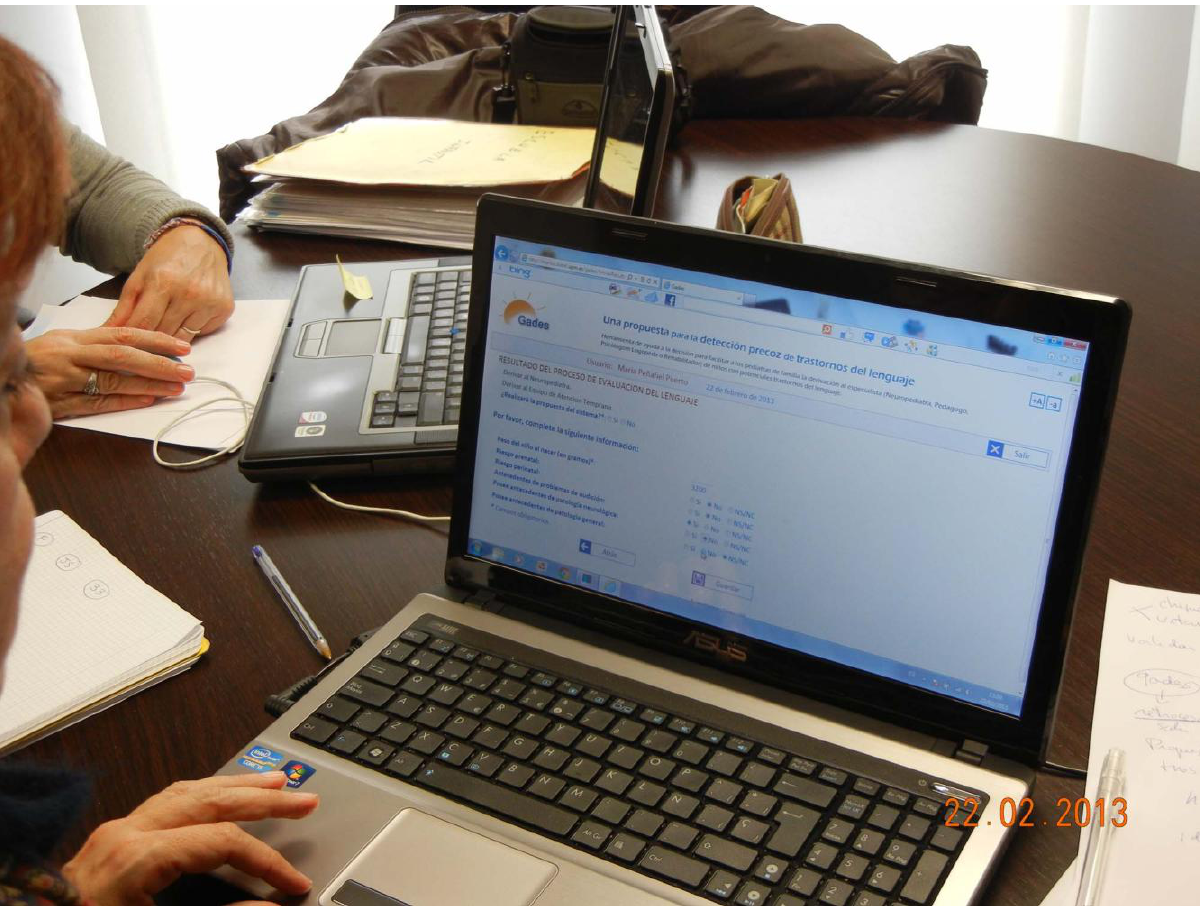
Figure 9. Language therapist realizing the system verification